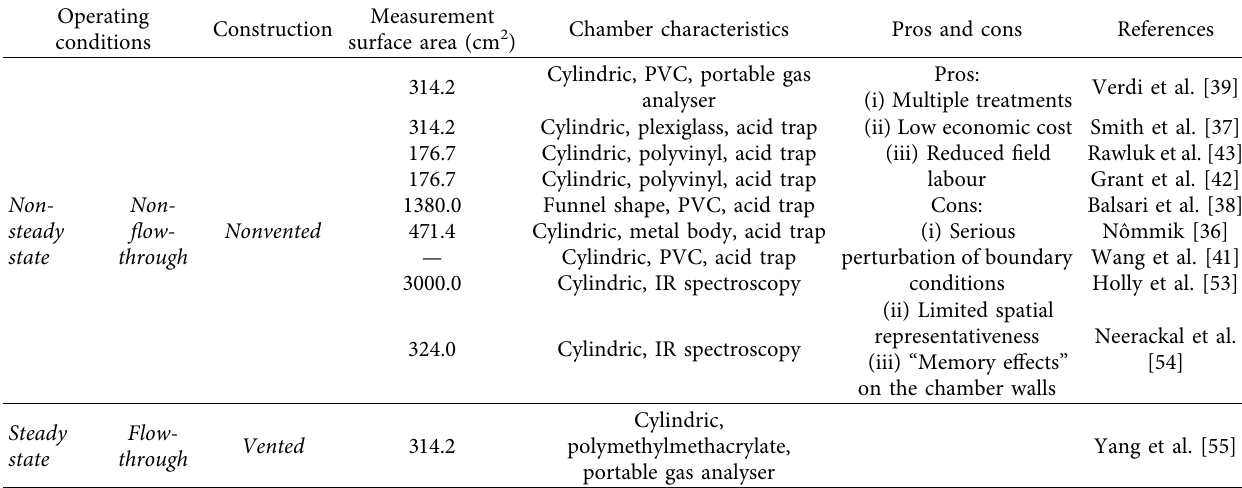
Table 1: Classification of chamber types according to